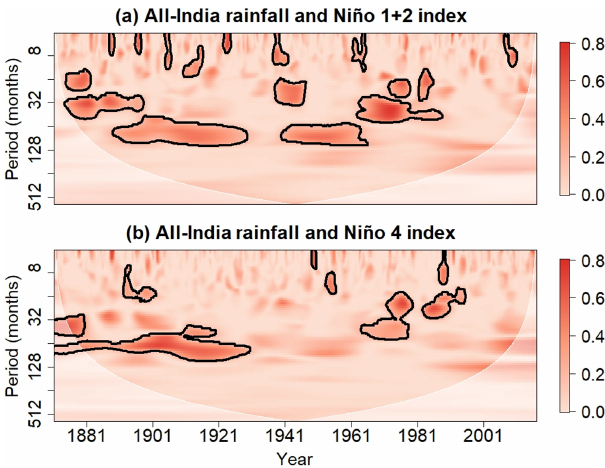
Figure 7. Wavelet coherence spectrum between AIR and time series for the (a) Niño 1 and 2 and (b) Niño 4 indices. Contours enclose re- gions of 5% cumulative area-wise significance. The shaded region represents the cone of influence, which is the region where edge effects are nonnegligible.